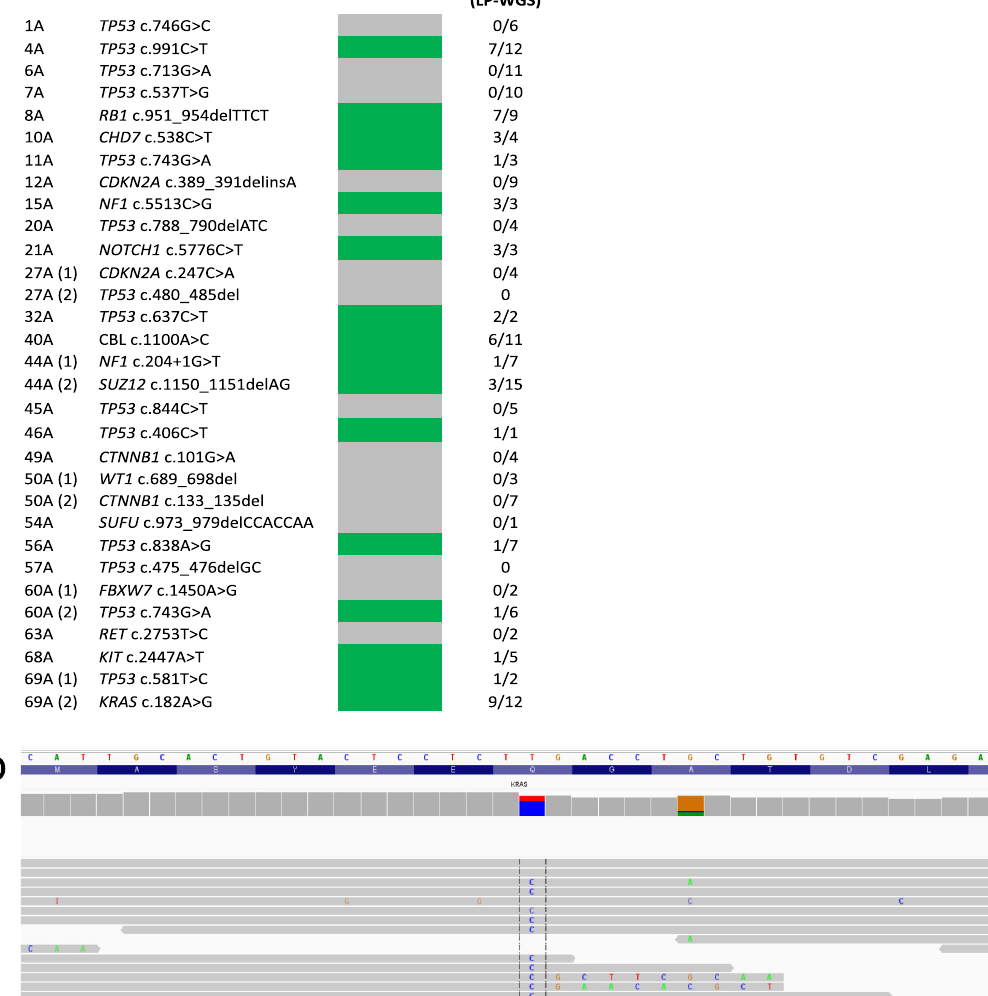
Fig. 5 Mutation detection using low-pass whole genome sequencing data from liquid biopsies. a Summary of all variants identi fi ed with the OncoKids NGS-panel from the tumor that were inspected for presence in the matched LP-WGS data from the LB ( n = 26 patients). (1) and (2) is used to refer to two different variants identi fi ed in the same patient. An indication of presence in LP-WGS is shown in green and an indication of absence is shown in gray. VAF is shown as a fraction of the number of reads for the variant allele over the total allele count. b IGV screenshot showing a KRAS c.182 A > G detection in LB from a germ cell tumor patient (wild-type allele = T, mutant allele =